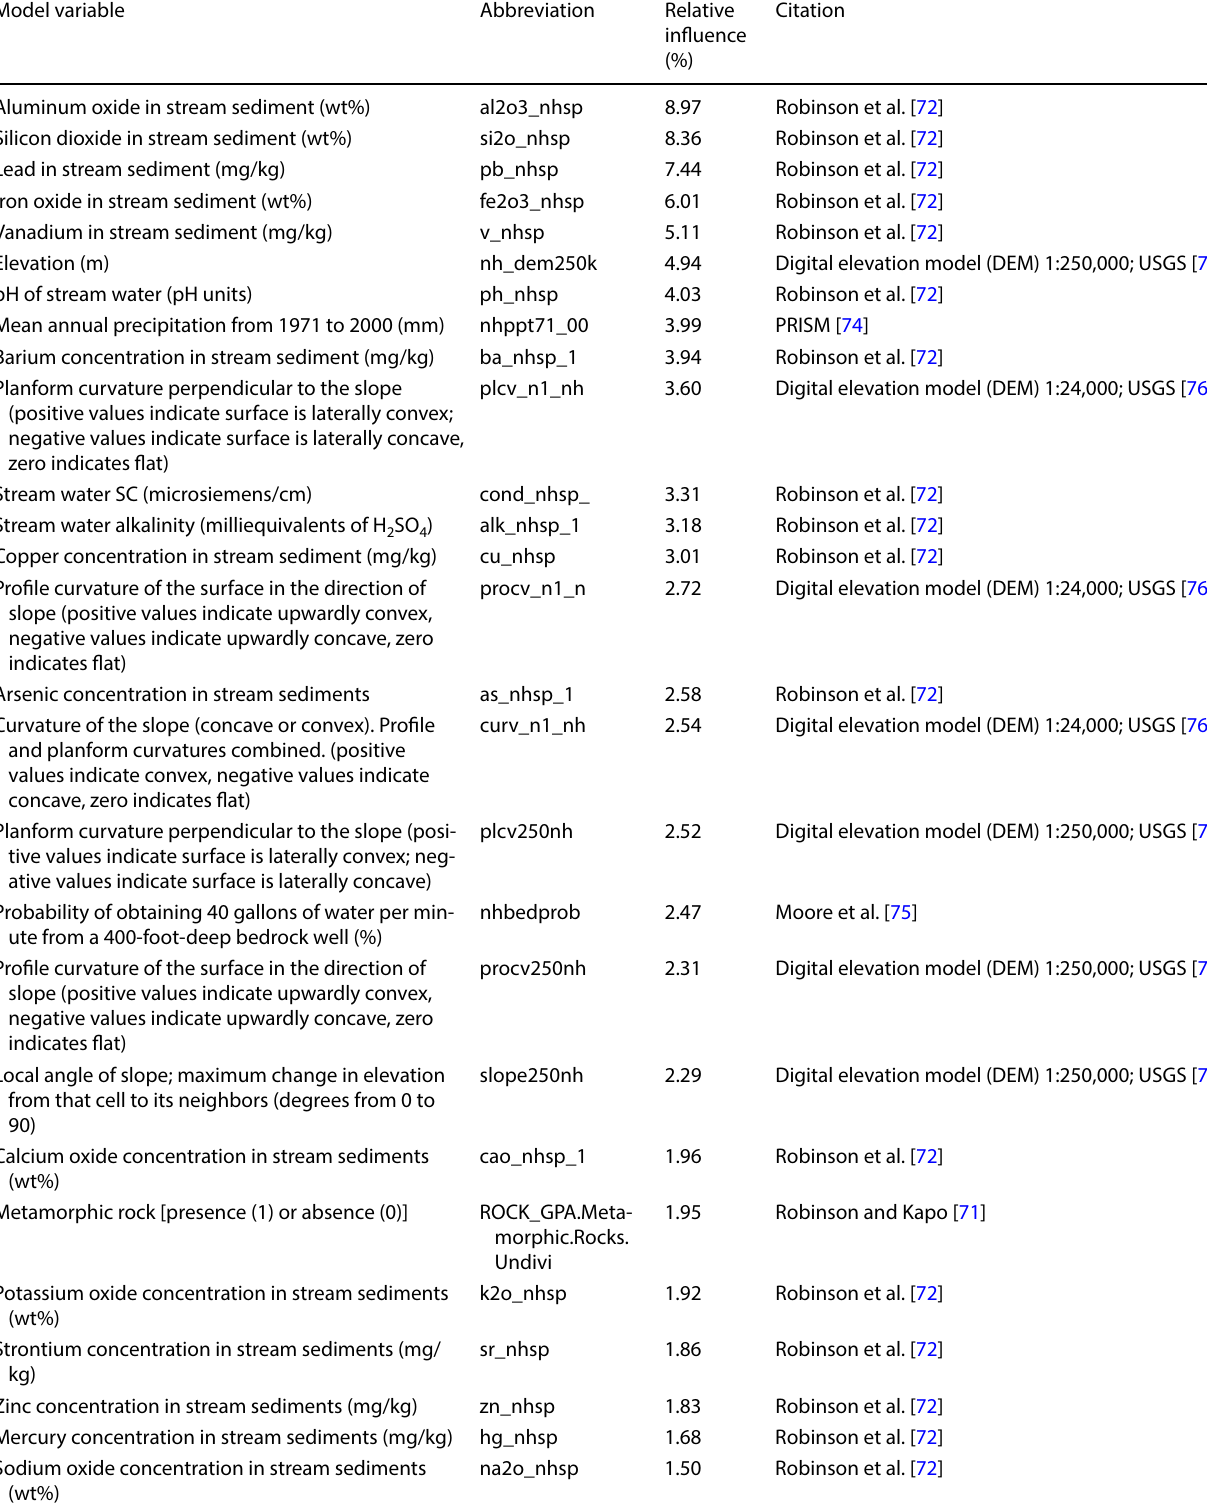
Table 3 Predictor variables for the final model with 30 variables and their relative influence in a boosted regression trees model to predict iron fouling in